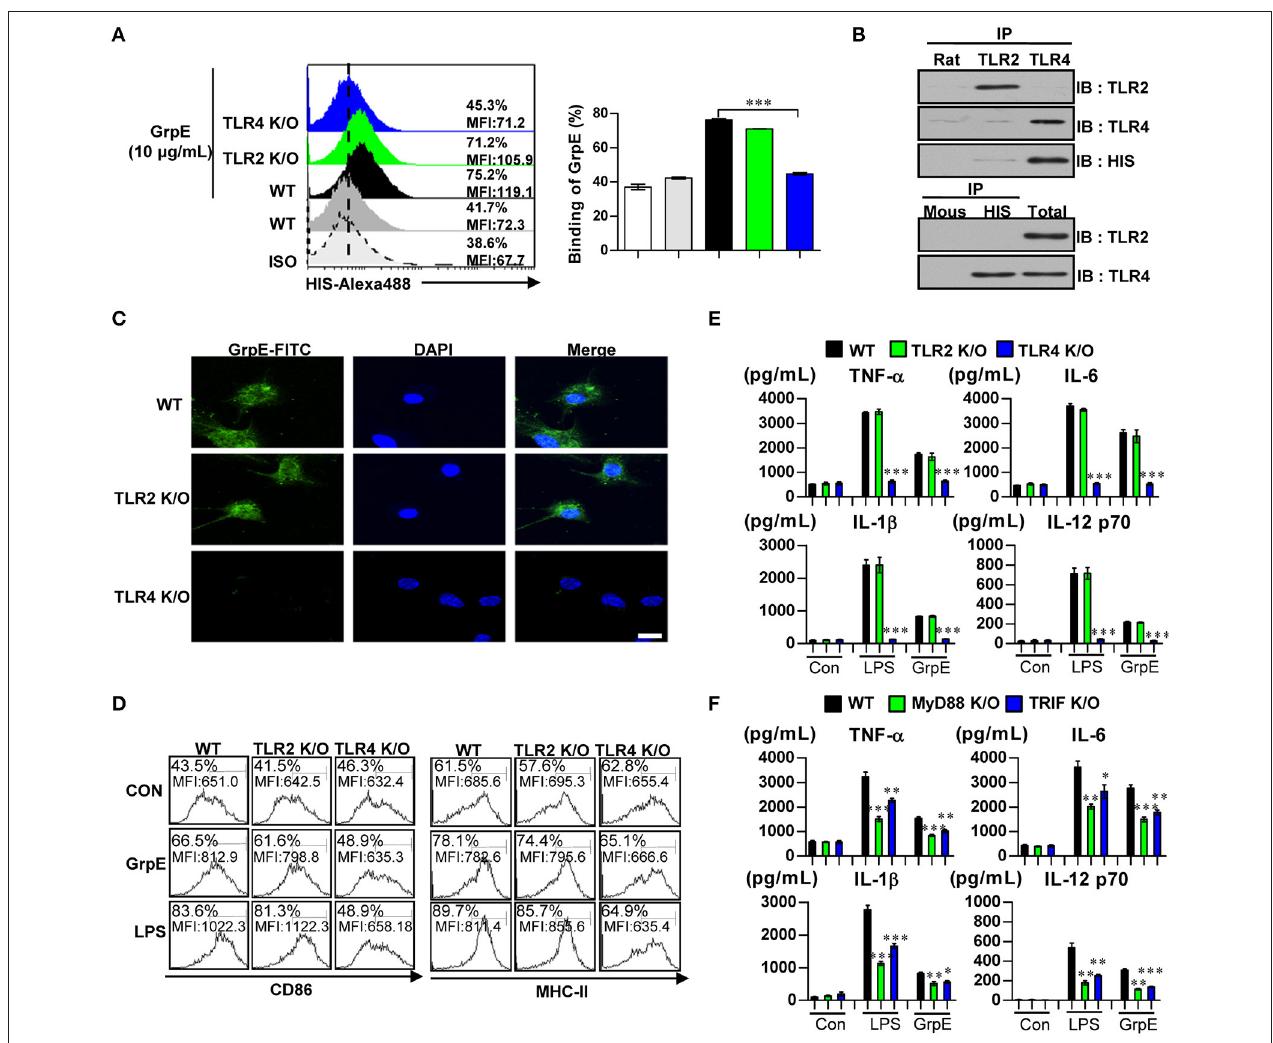
FIGURE 3 | Induction of DC maturation by GrpE via MyD88/TRIF-dependent TLR4 signaling pathway. (A) DCs derived from WT-, TLR2 K/O-, and TLR4 K/O-mice were treated with GrpE (10 µ g/mL) for 1h and stained with an Alexa488-conjugated anti-His mAb. The percentage of positive cells is shown in each panel. Bar graph data are expressed as the mean ± SD ( n = 3 samples); *** p < 0.001. (B) DCs were treated with GrpE for 6h. The cells were harvested and cell lysates were immunoprecipitated with anti-rat IgG, anti-mouse IgG, anti-His, anti-TLR2, or anti-TLR4 mAbs, and proteins were visualized by immunoblotting with anti-His, anti-TLR2, or anti-TLR4 Abs. One representative plot from three independent experiments is shown. (C) Fluorescence intensities of anti-GrpE bound to GrpE-treated DCs. DCs derived from WT-, TLR2 K/O-, and TLR4 K/O-mice were treated with GrpE (10 µ g/mL) for 1h, fixed, and stained with DAPI and FITC-conjugated anti-GrpE Ab (Scale bar: 10 µ m). One representative plot from three independent experiments is shown. (D) DCs purified from WT-, TLR2 K/O-, and TLR4 K/O-mice were treated with GrpE and LPS, respectively. After 24h, we measured the expression of CD86 and MHC class II on DCs by flow cytometry. Data are representative result of three experiments. (E) IL-12p70, TNF- α , IL-6, and IL-1 β in supernatants of GrpE- or LPS-treated DCs cultured from WT-, TLR2 K/O-, and TLR4 K/O-mice was measured with ELISA. (F) DCs derived from WT-, MyD88 K/O-, and TRIF K/O-mice were treated with GrpE and LPS for 24h. The amount of IL-12p70, TNF- α , IL-6, and IL-1 β in culture medium of GrpE-treated DCs was measured by ELISA. All data are expressed as the mean ± SD ( n = 3 samples) of representative result in three experiments and statistical significance (* p < 0.05, ** p < 0.01, or *** p < 0.001) vs. GrpE-treated WT-DC groups (Black bar). Con denotes untreated